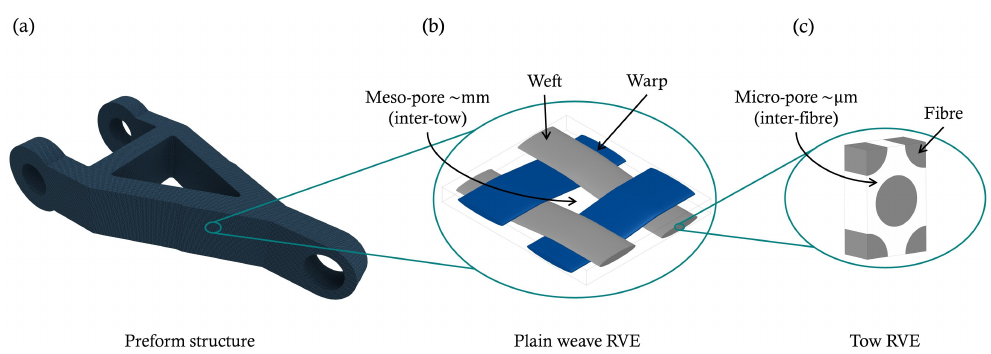
Figure 4. Composite torque link: ( a ) boundary conditions; and ( b ) geometric details.